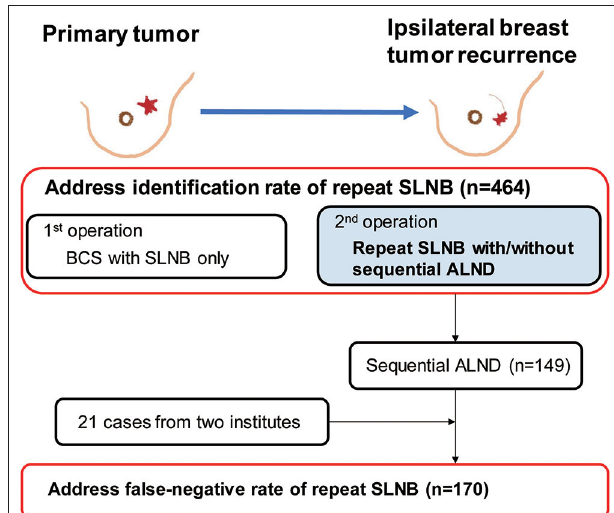
FIGURE 2 | Flowchart for data curation in order to address the identification rate and false-negative rate of repeat sentinel lymph node biopsy. A total of 1,212 cases of 20 articles were found, 464 subjects met inclusion criteria about first breast cancer surgery. Among these, repeat sentinel lymph node was performed in 335 patients, resulting in 72.2% of identification rate for reSLNB. Except 1 article, sequential ALND was performed in 149 patients in 19 articles. Then we added 21 patients who underwent sequential ALND after reSLNB from two institutions. Finally, a total of 170 patients were analyzed for false-negative rate of reSLNB. BCS, breast conserving surgery; SLNB, sentinel lymph node biopsy; ALND, axillary lymph node dissection.